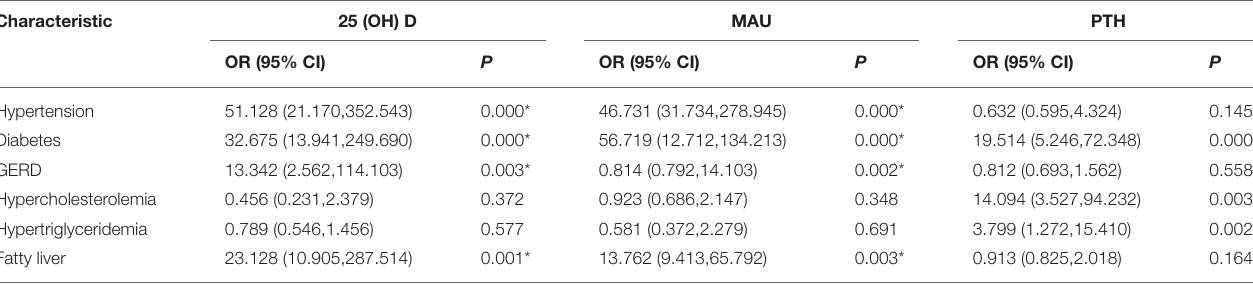
TABLE 4 | Multivariable logistic regression analysis of factors associated with 25 (OH) D, MAU. and PTH.